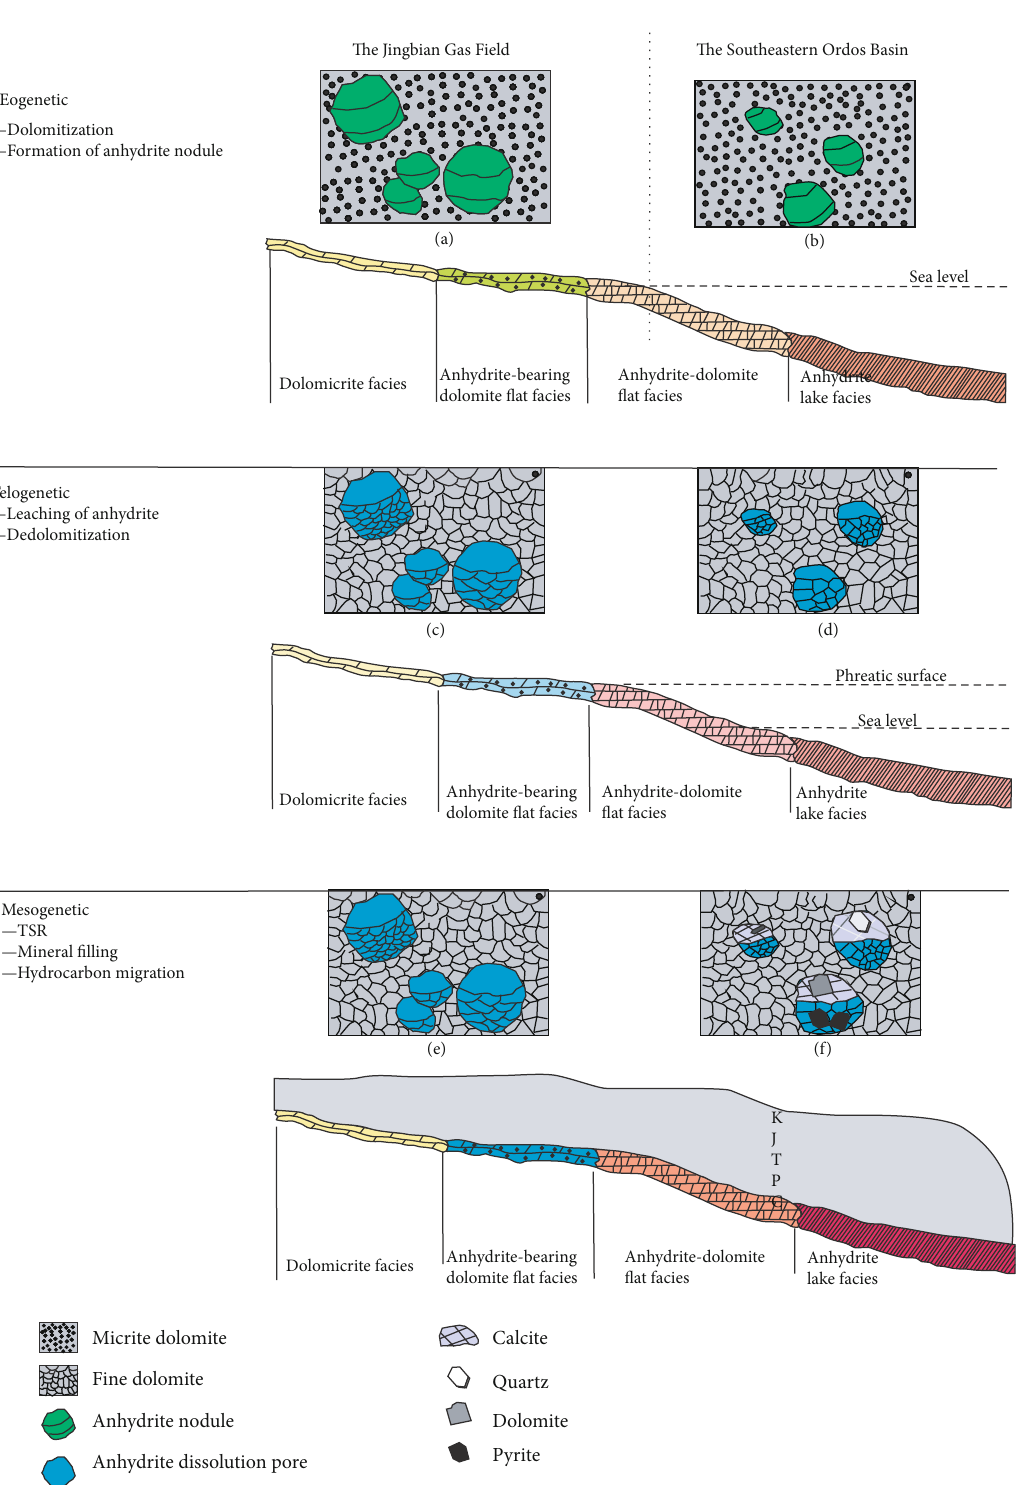
Figure 9: Diagenetic evolution comparison of minerals fi lling in anhydrite dissolution pores in the Ordovician Majiagou Formation of the southeastern Ordos Basin and the Jingbian Gas